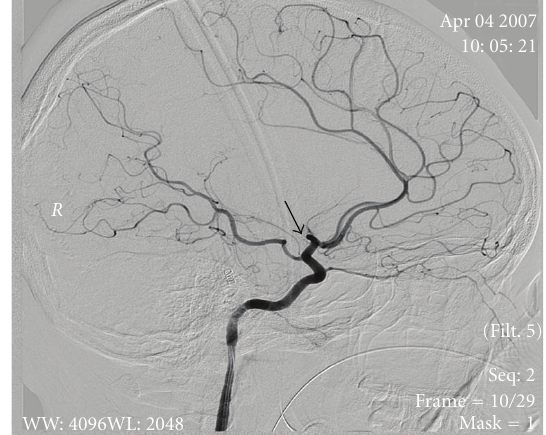
Figure 3: Sagittal view of angiography arrow pointing to the area the Middle Cerebral Artery occlusion.